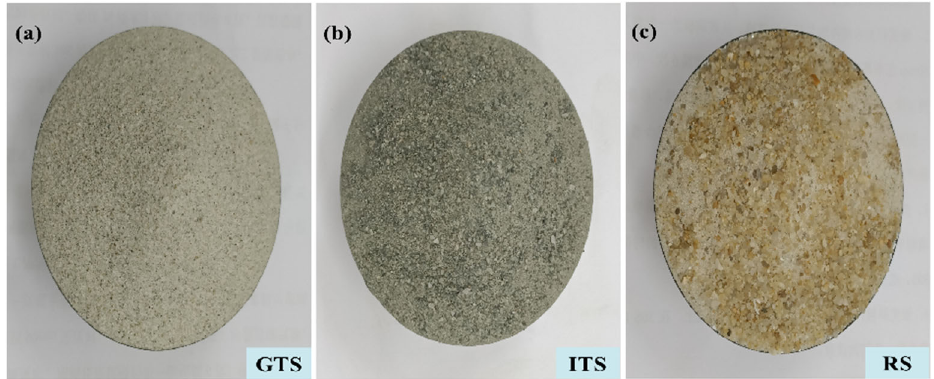
Figure 2. Samples of three fine aggregates. ( a ) GTS, ( b ) ITS, ( c )